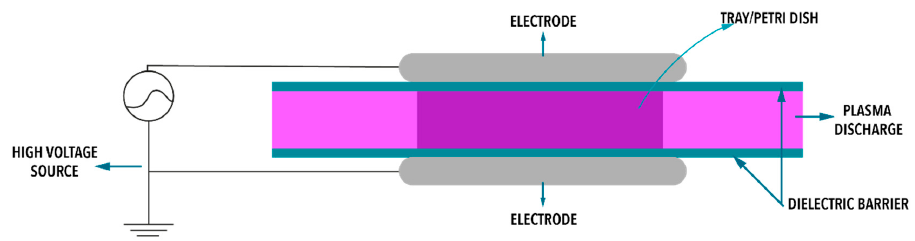
Figure 2. Schematic of the cold atmospheric plasma (CAP) setup.